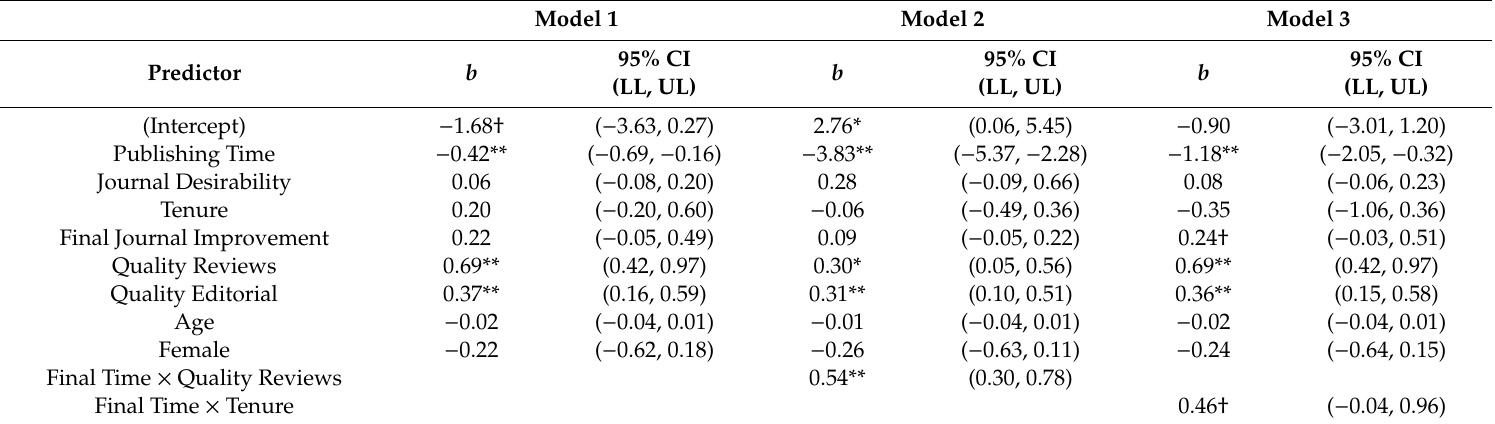
Table 3. Regression